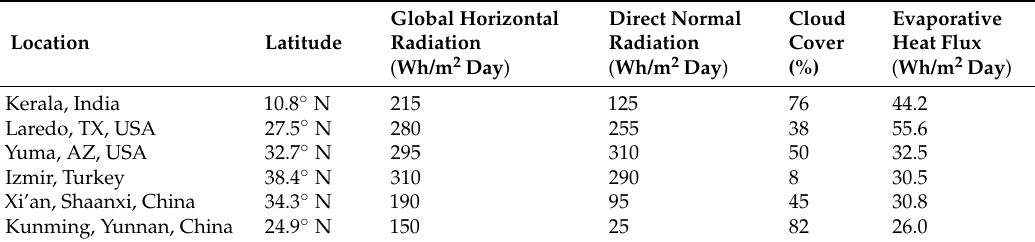
Table 4. Solar radiation and cloud cover in adobe